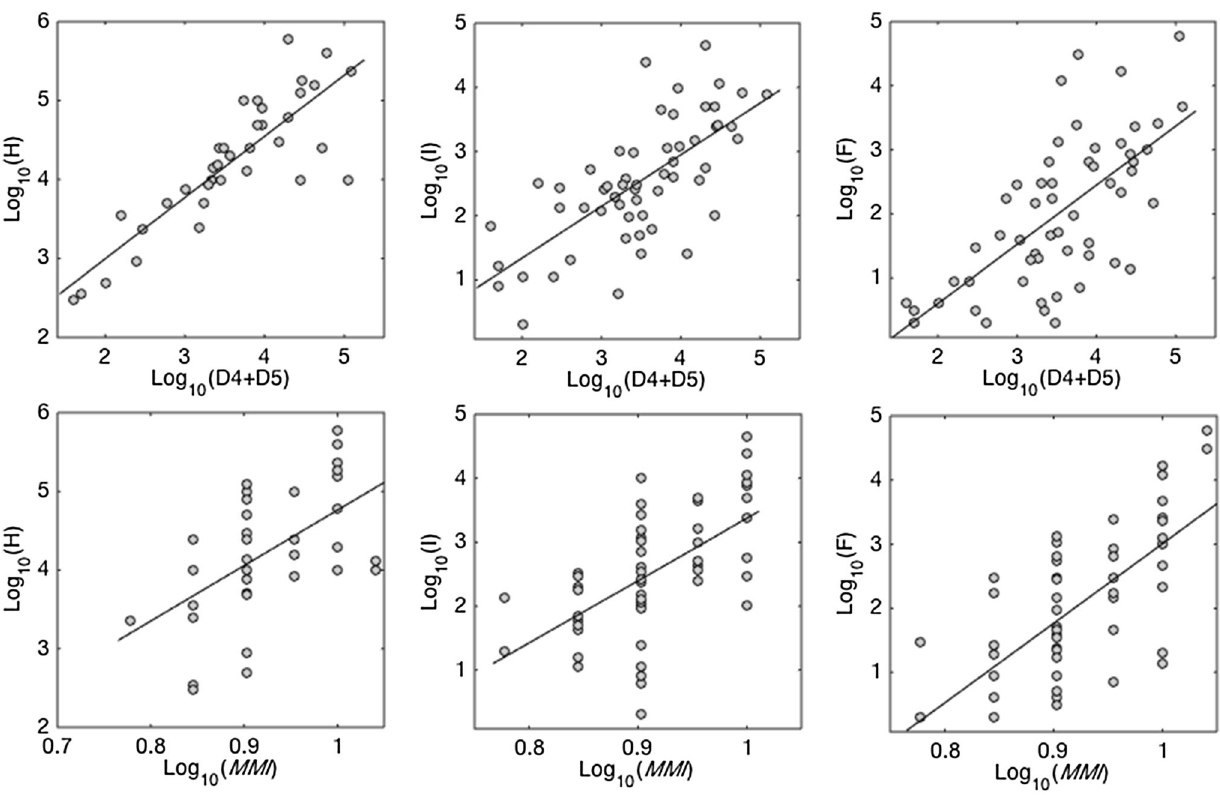
Fig. 4 Human losses (home loss, injuries, fatalities) versus damage ( a ) and intensity ( b ) as hazard-related predictor variables. The black lines correspond to the best-fit regression